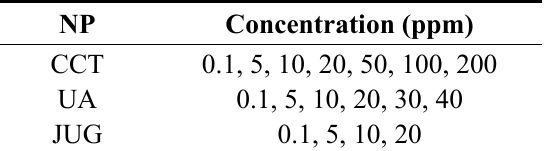
Table 5. Natural products (NP) used to assess bacterial attachment where, JUG, juglone; UA, usnic acid; CCT, C. crispus toluene soluble. Units: ppm = μ g mL − 1